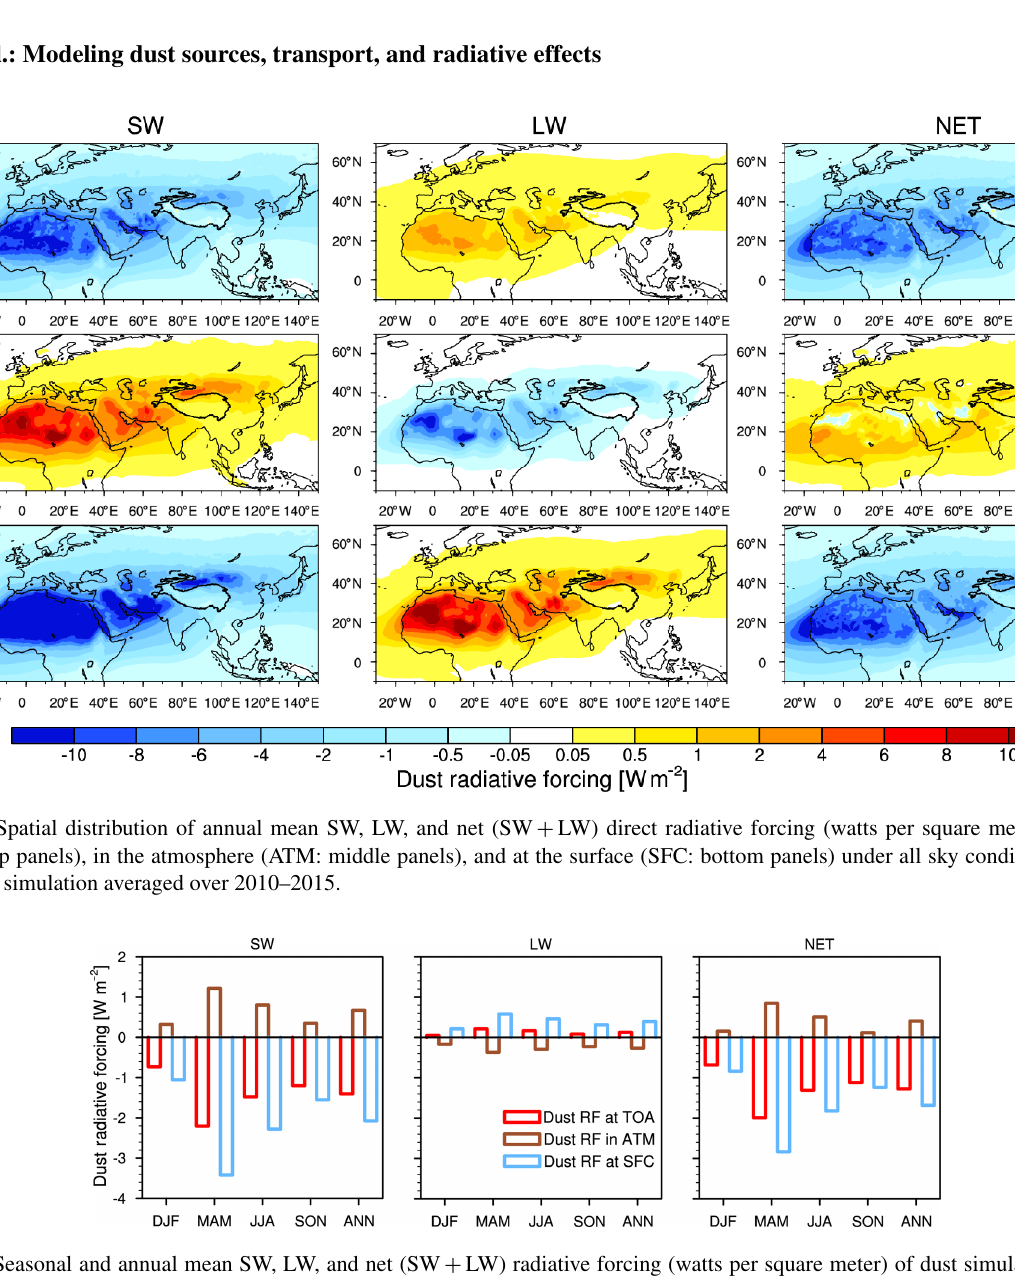
Figure 13. Seasonal and annual mean SW, LW, and net (SW + LW) radiative forcing (watts per square meter) of dust simulated by WRF- Chem for the period of 2010–2015 over the TP. Negative values represent downward radiation.